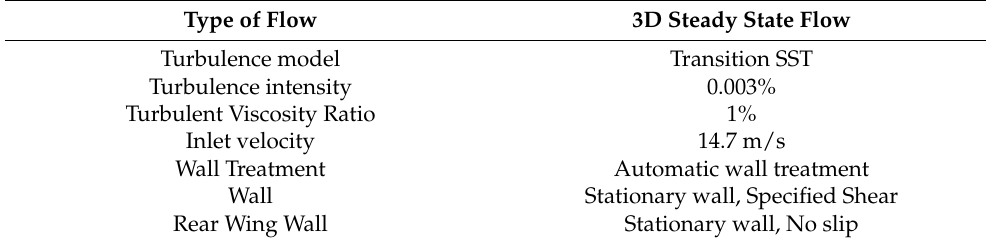
Table 1. Boundary